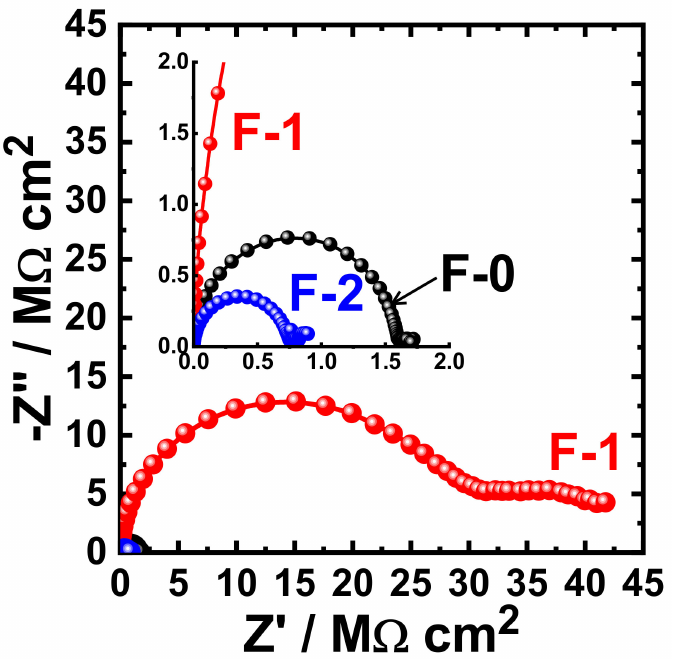
Figure 19. Typical Nyquist plots obtained for F-0, F-1, and F-2 after their immersion in 3.5% NaCl solutions for 30